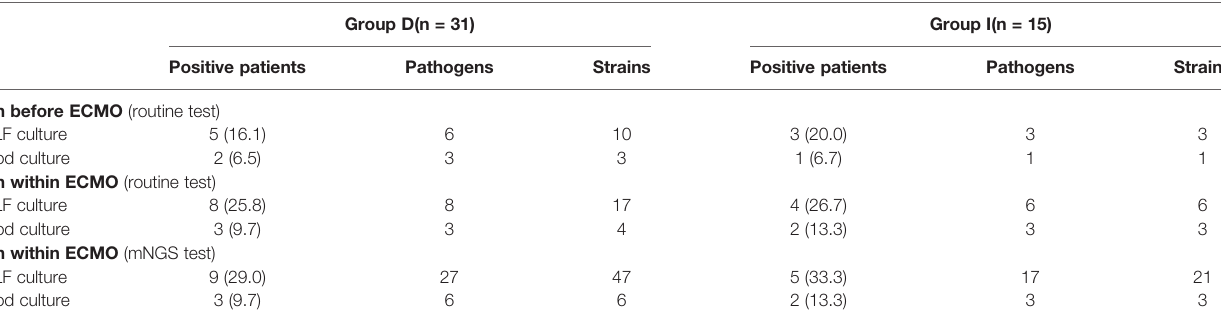
TABLE 3 | Pathogens detected by mNGS and routine test of immunocompromised patients supported with vv-ECMO. Group D(n = 31) Group I(n = 15) Positive patients Pathogens Strains Positive patients Pathogens